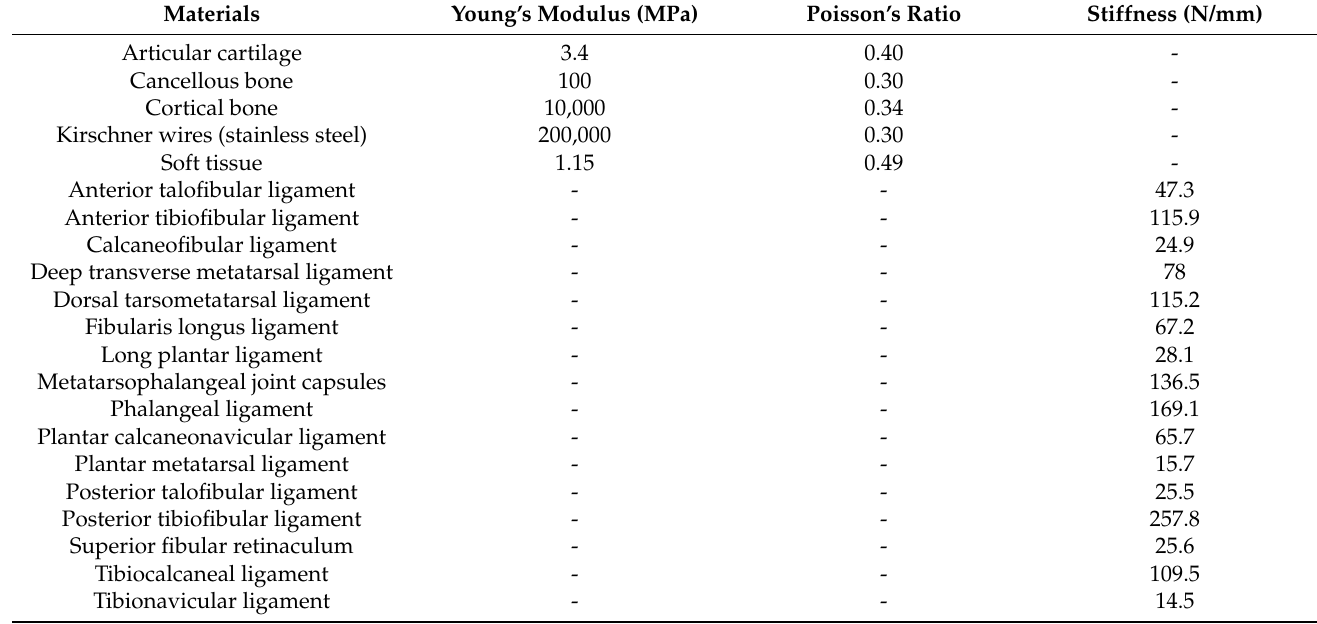
Table 1. The material properties of the numerical models for the treatment of hallux valgus